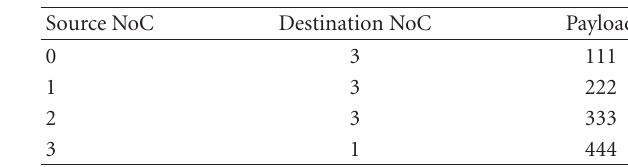
Table 1: Initial source and destination information used to set up communication between NoCs.